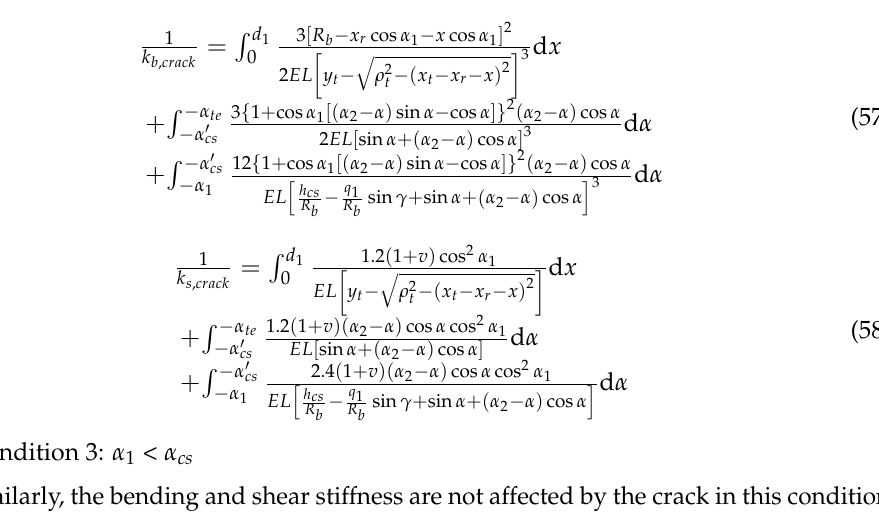
depth q ( z ), angle 𝛾 ( z ) and height l ( z ) for each slice can be regarded as constant. Namely,